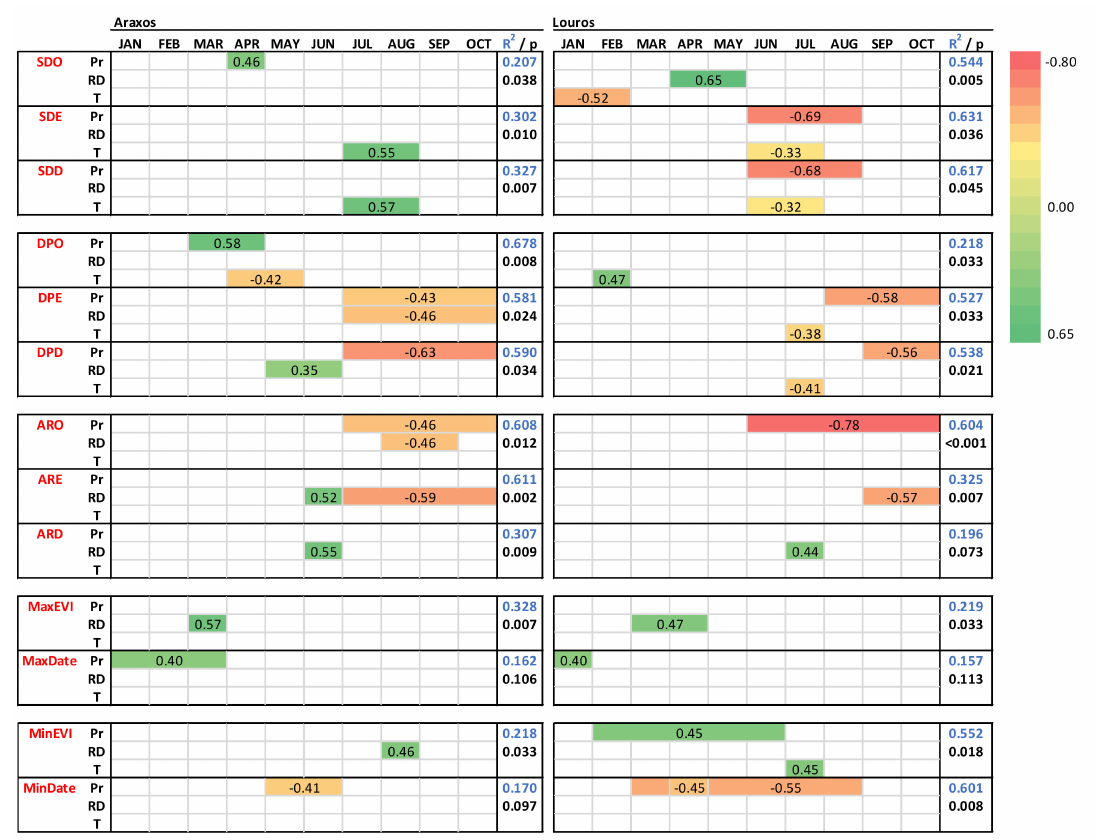
Figure 7. Climatic control on phenological events and transitions of P. fruticosa in the two sites as derived by single or multiple linear regressions. The phenological metrics are: Spring drop onset (SDO); spring drop end (SDE); spring drop duration (SDD); Dry period onset (DPO); dry period end (DPE); dry period duration (DPD); Autumn revival onset (ARO); autumn revival end (ARE), autumn revival duration (ARD); MaxEVI the maximum value of EVI; MaxDate, the date it is achieved; MinEVI the minimum value of EVI; MinDate, the date it is achieved. For each phenological event, the partial regression coefficient(s) of the most significant climatic variable(s) (precipitation (Pr), number of rain days (RD) and temperature (T)) of single or multiple months (top line) is presented in the corresponding colored horizontal lines, according to the chromatic scale appearing in the right. The regression coefficient (R 2 ) of the model which includes the factors influencing each event and the corresponding level of significance (p) is presented in the right column of each